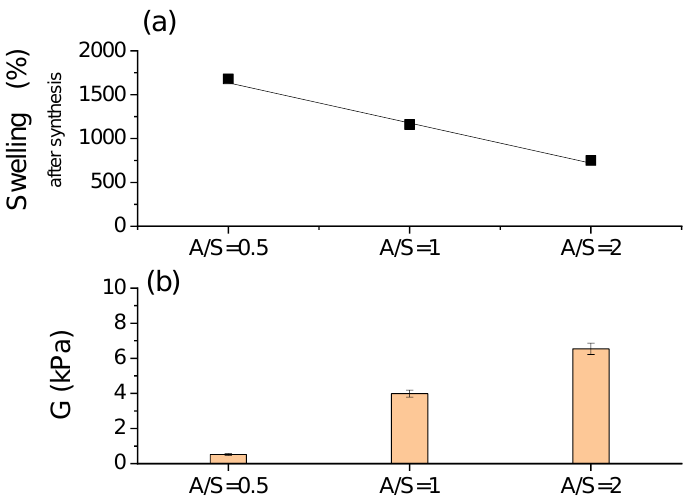
Figure 7. Swelling ratio (Q) ( a ) and shear moduli ( b ) of HPMC-g-poly(AM-co-SPA) hydrogels after synthesis.